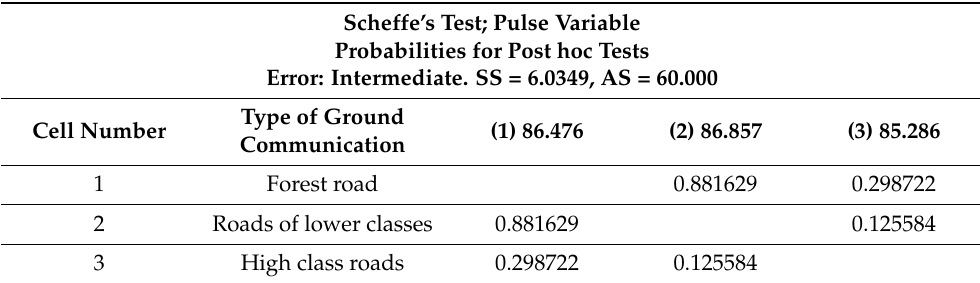
Table 8. Post hoc test to analyze the variance of heart rate values depending on the type of communi- cation when driving the timber